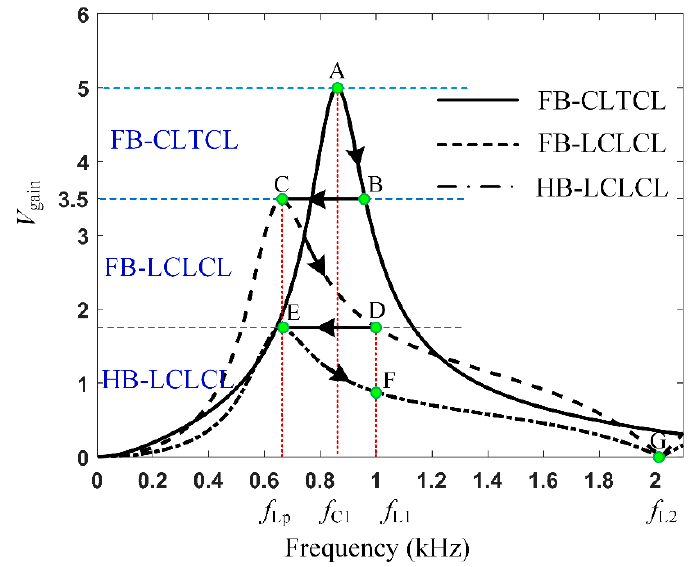
Figure 5. Integrated DC voltage gain curve.